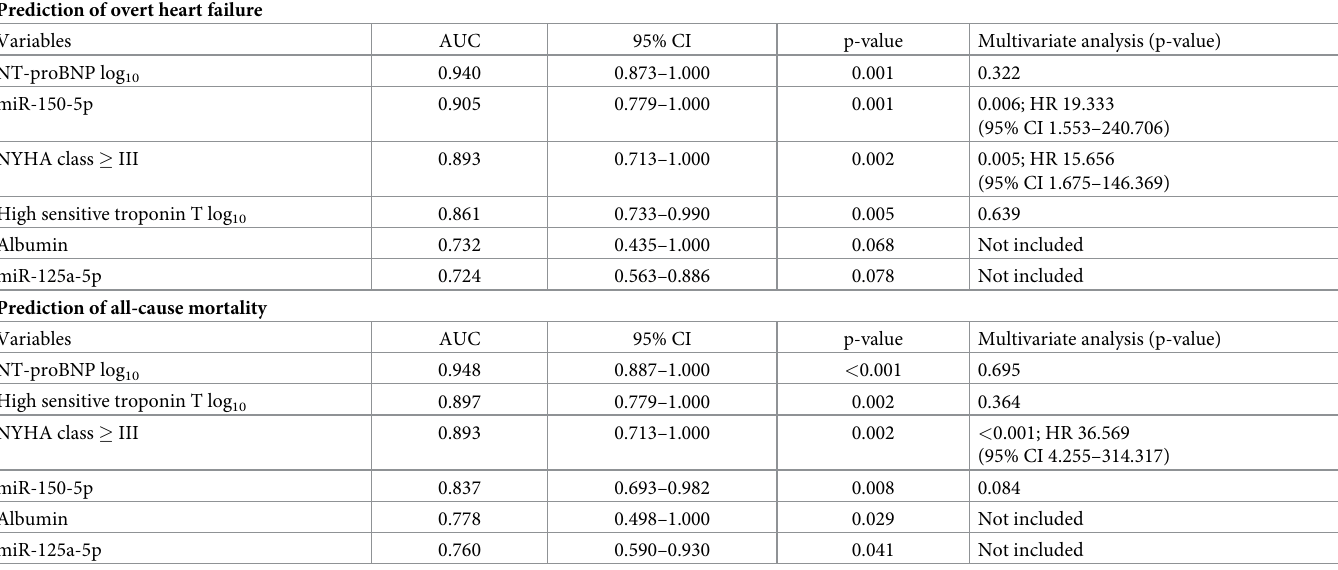
Table 3. Results of ROC curve and multivariate analysis for the prediction of overt heart failure and all-cause mortality. Prediction of overt heart